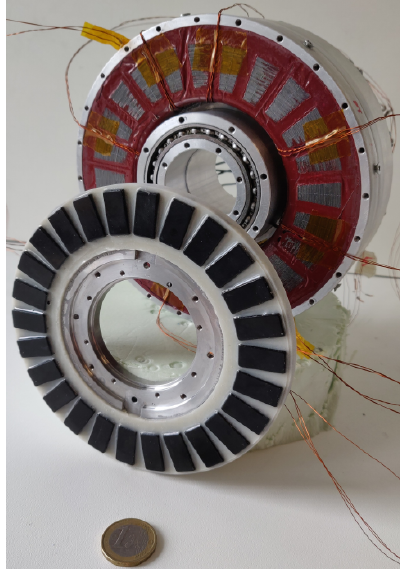
Figure 2. Prototype Yokeless and Segmented Armature Axial Flux Permanent Magnet Synchronous Machine used throughout this work; it has two rotors and a single stator. For visualization purposes only a single rotor is shown here. Its specifications are given in Table